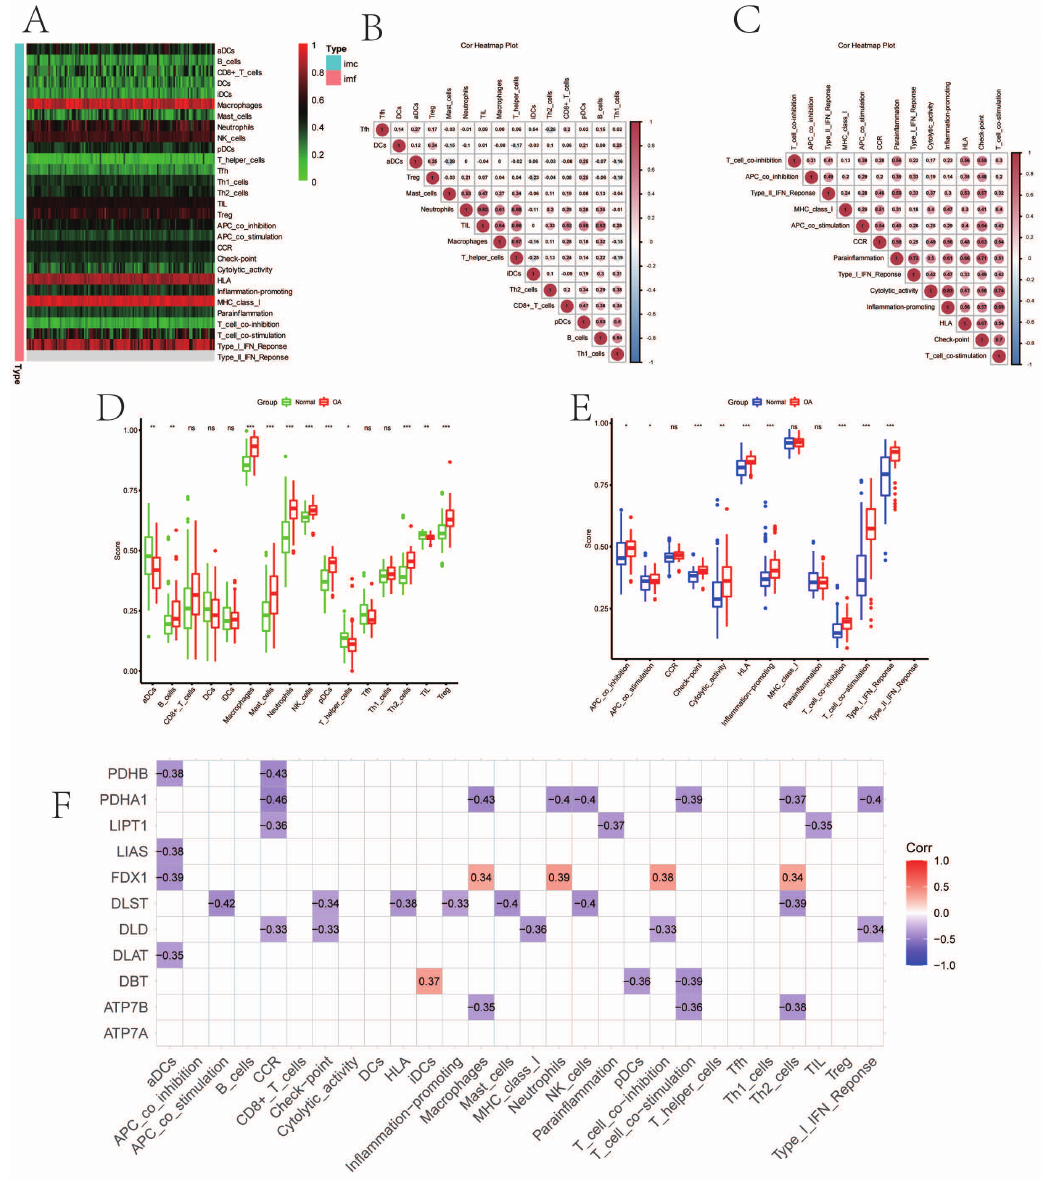
Figure 2. The immune landscape and correlation analysis between CRGs and immune infiltration in OA. ( A ) Heatmap showing the expression characteristics of immune cells and immune function in OA and normal tissues. Red represents high expression levels, while green represents low expression levels. ( B , C ) The correlation analysis of immune cells ( B ) and immune function ( C ); positive correla- tion is represented by red, while negative correlation is represented by blue. ( D , E ) Boxplot showing differences in the expression of immune cells ( D ) and immune function ( E ) in OA and normal tissues. ( F ) Correlation between immune infiltration and CRGs; positive correlation is represented by red, while negative correlation is represented by blue. (For all figures: * represents p < 0.05, ** represents p < 0.01, and *** represents p < 0.001). CRGs, cuproptosis-related genes; OA,